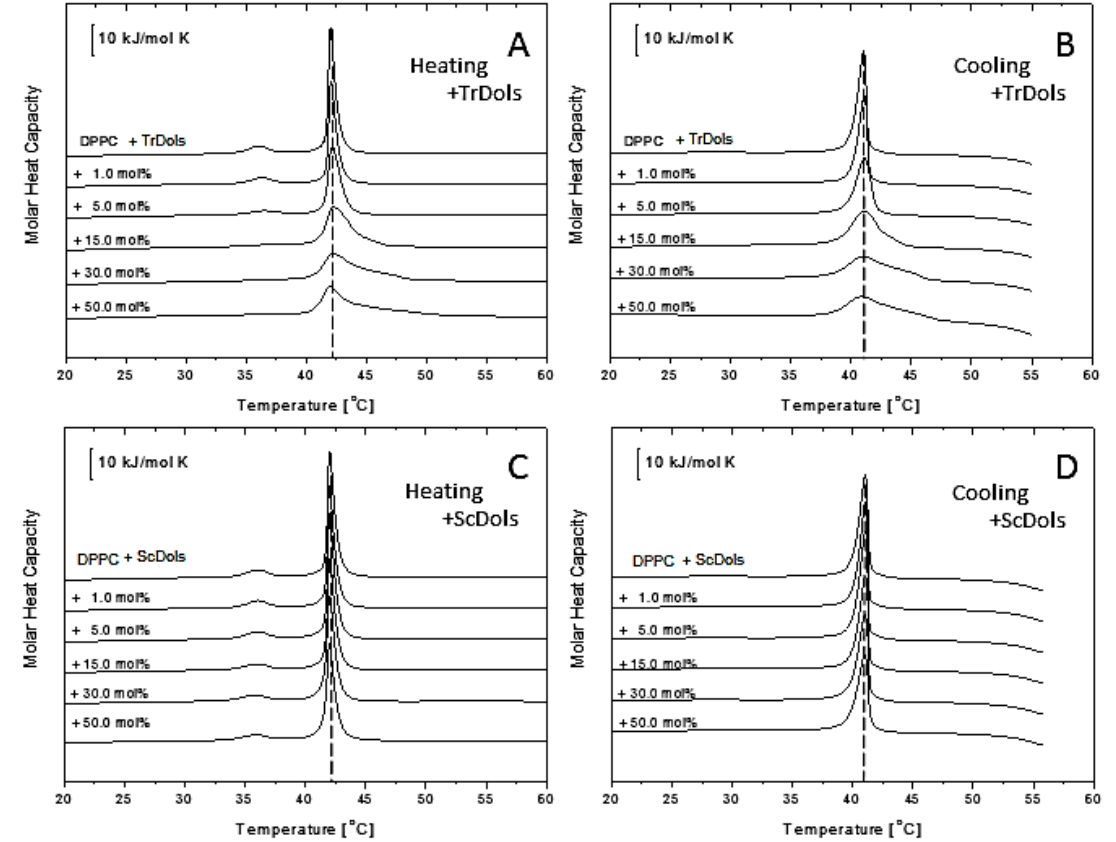
Figure 7. Influence of dolichols on thermal properties of 1,2-dipalmitoyl- sn -glycero-3-phosphatidylocholine (DPPC) membranes. Differential scanning calorimetry (DSC) of multilamellar vesicles (MV) obtained in the heating ( A , C ) and cooling ( B , D ) modes for TrDols ( A , B ) and ScDols ( C , D ) are shown. Scans were obtained at the rate of 1 ◦ C min − 1 ; representative scans of three independent runs are shown. Table 4. Thermodynamic parameters of fully hydrated multilamellar DPPC liposomes supplemented with S. cerevisiae or T. reesei dolichols.